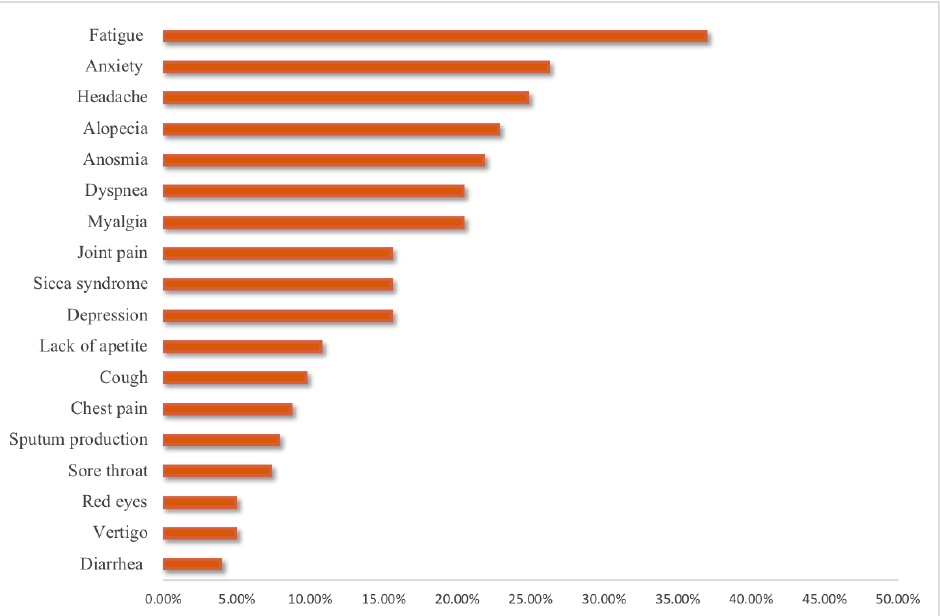
Figure 1. Persistence of symptoms in outpatients who had recovered from COVID-19. To assess the association influence of gender, age, comorbidities, and treatment on symptom persistence, a comparison was performed with asymptomatic patients. A higher proportion and increased risk of persistent symptoms were observed in female symptomatic patients when compared to female asymptomatic patients (69.5% vs. 43.6%, OR = 2.95, 95% CI 1.56 – 5.57, p = 0.001), or those treated with macrolides (41.1% vs. 18.2%, OR = 3.13, 95% CI 1.47 – 6.67, p = 0.003). Smoking was observed in higher proportion of the asymptomatic group (20.5% vs. 38.2%, OR = 0.42, 95% CI 0.21 – 0.82, p = 0.012) (Table 2).